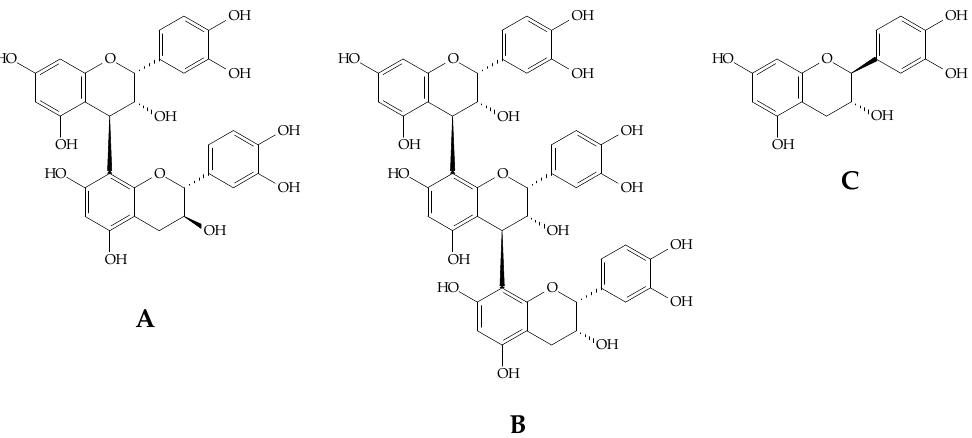
Figure 2. Structures of the major constituents of X. americana L. stem bark ( A ) Procyanidin B; ( B ) Procyanidin C; ( C ) Catechin/epicatechin.